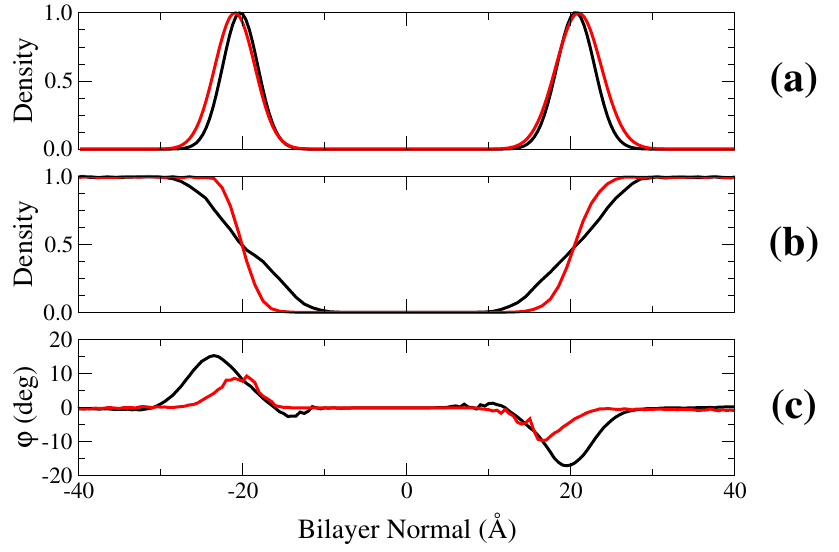
Figure 2. Analysis of the pure bilayer systems: ( a ) mass density of head groups; ( b ) water number density; and ( c ) average orientation of water molecules with respect to the bilayer plane (the angle between the dipole vector and the x-y plane). Black and red lines represent systems with POPC and NODS lipids, respectively. Densities are calculated using the density profile extension in VMD